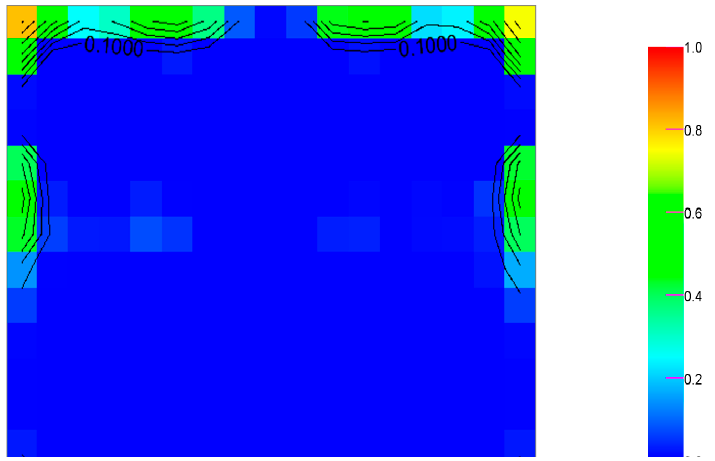
Figure 8. A graph of the fraction of occupied hours that illuminance falls below 450 lux when the system is calibrated to deliver 500 lux at the critical point shows almost no deficiency over the primary work